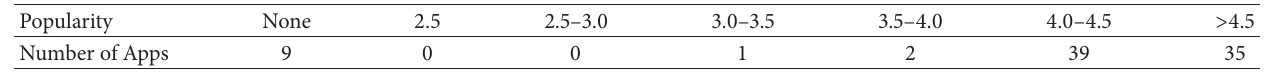
Table 2: Initial distribution of malware Apps by popularity in July 2011 taking into account repackaging.